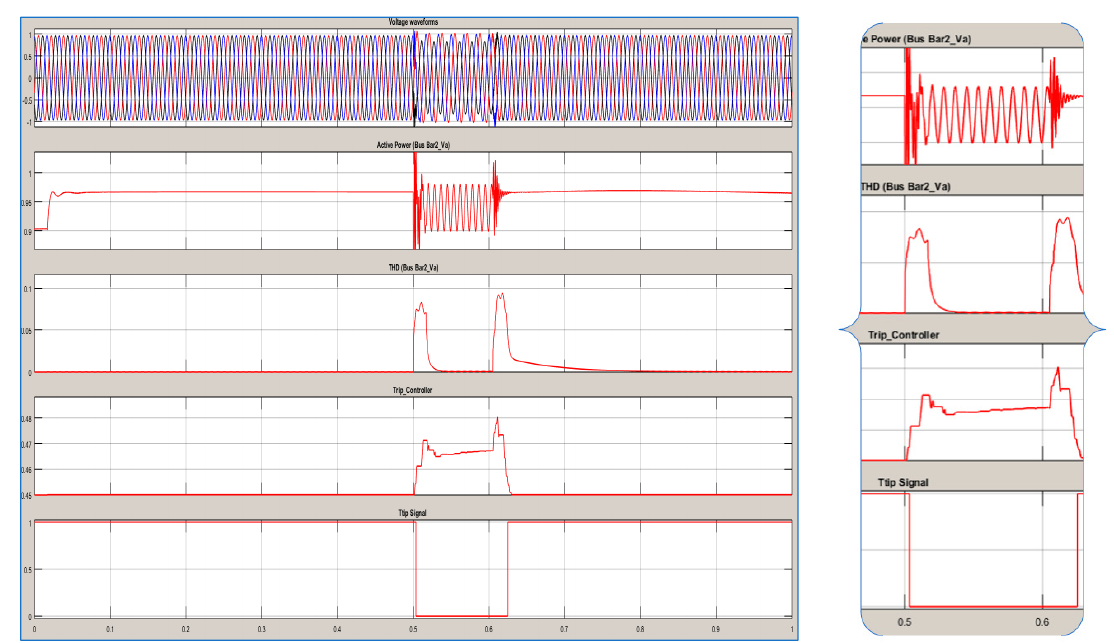
Figure 17. Double line (BC_G) fault voltage waveform.